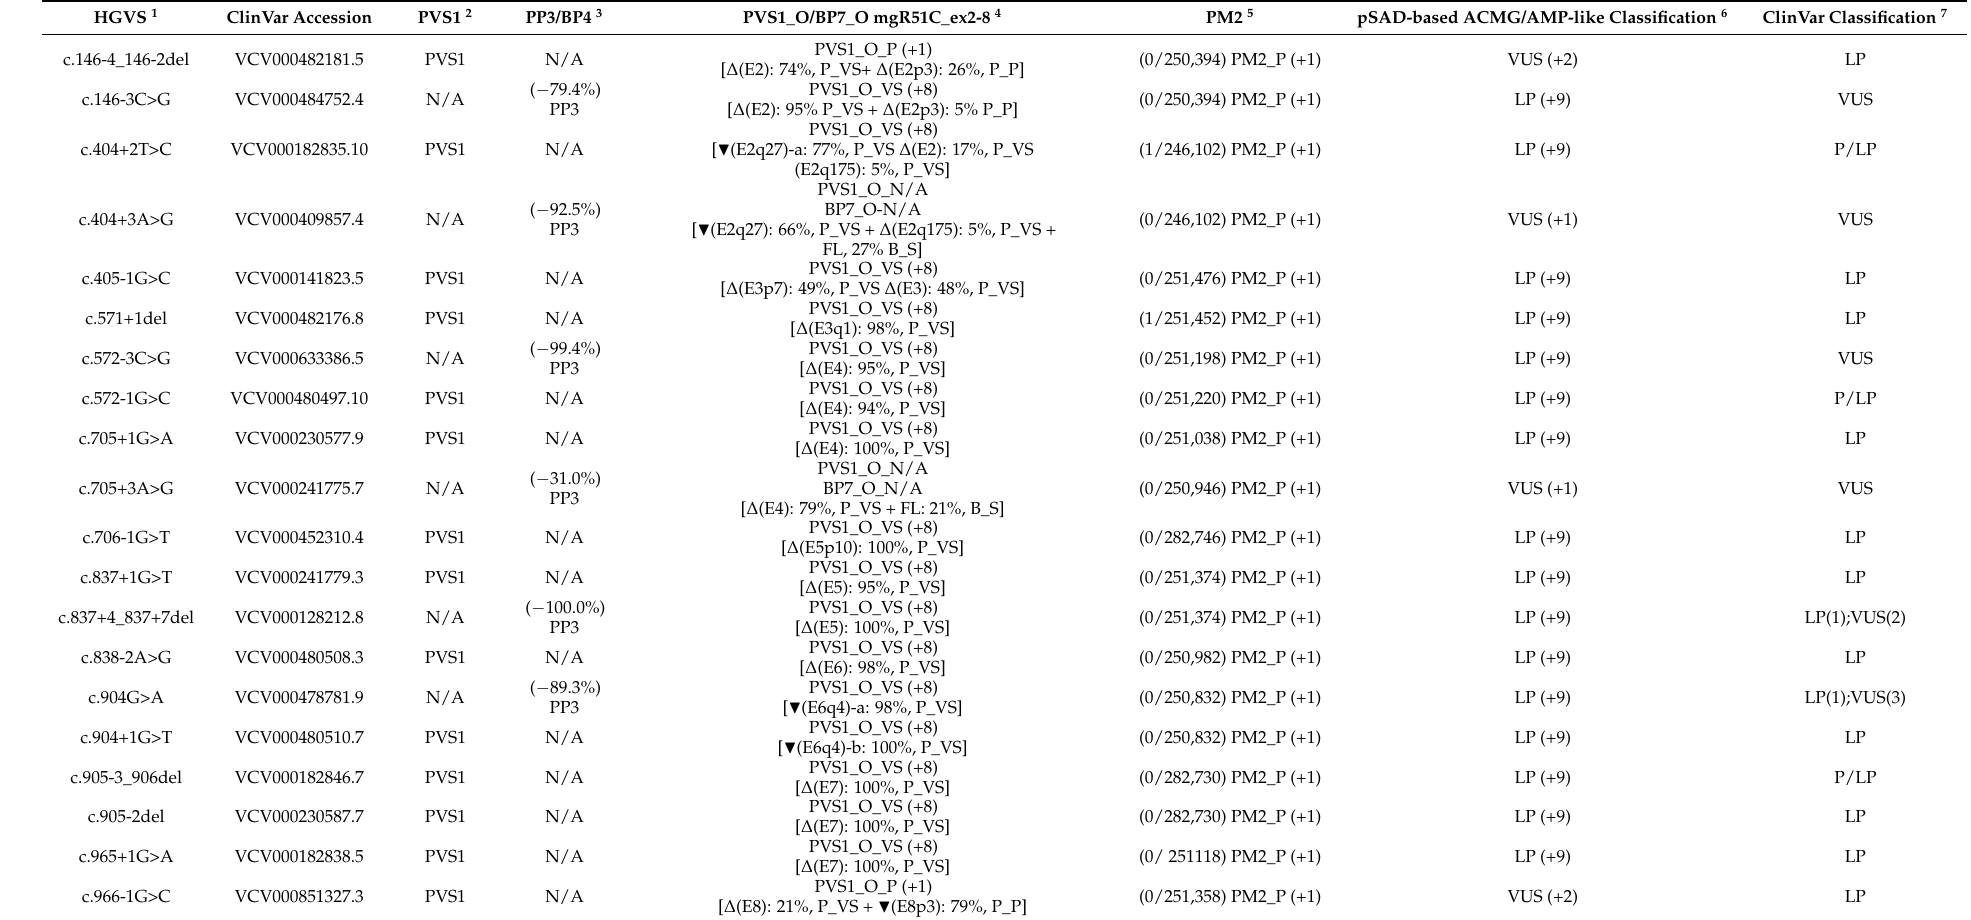
Table 2. Proposed clinical classification of RAD51C variants according to ACMG/AMP-based